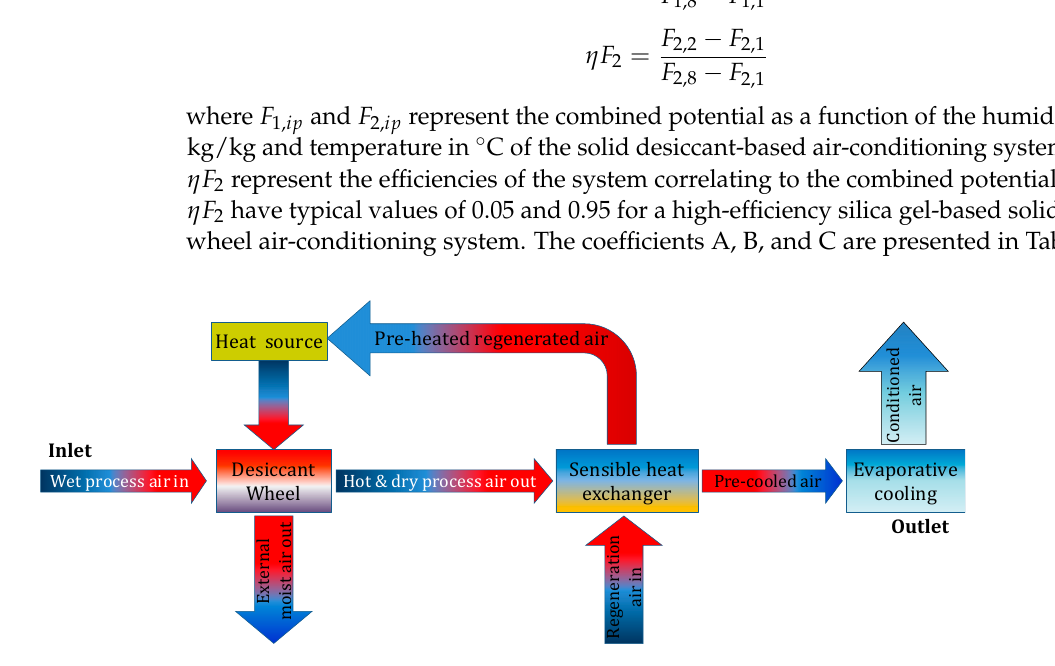
Energies 2021 , 14 , x FOR PEER REVIEW